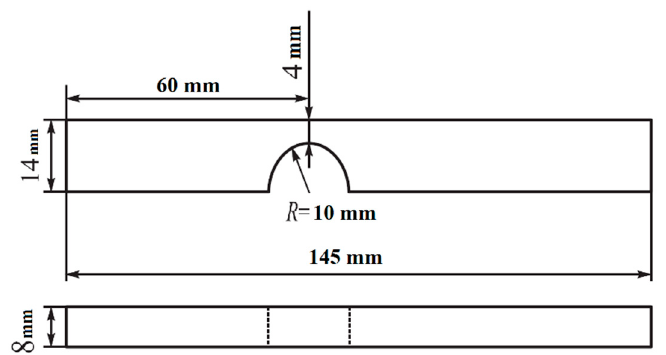
Figure 1. Geometry of the cycle fatigue test samples: side and top views.